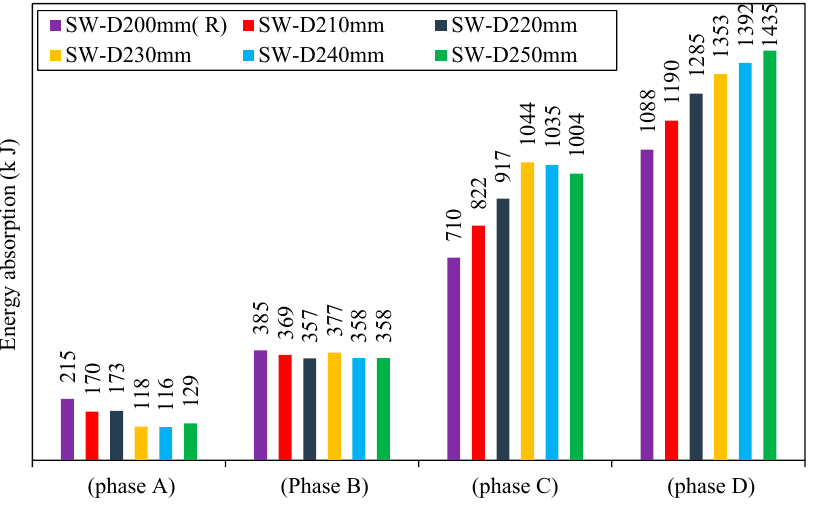
Figure 28. Energy absorption of group 4.